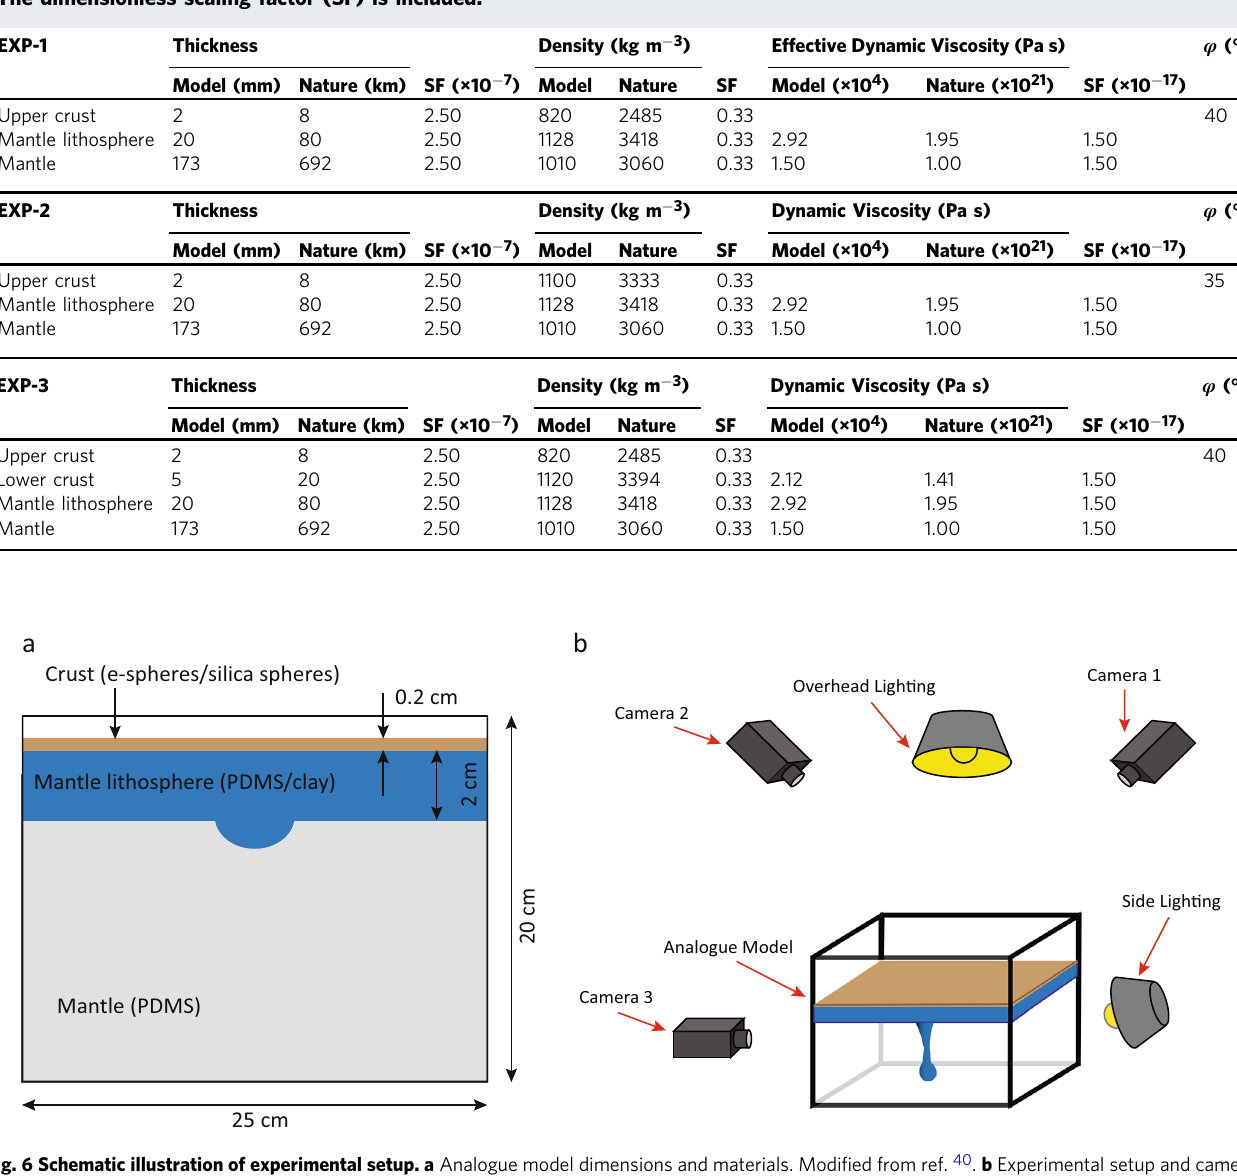
Table 1 Experimental setup Rheologic properties of materials used in the analogue models with a comparison to nature. The dimensionless scaling factor (SF) is included.